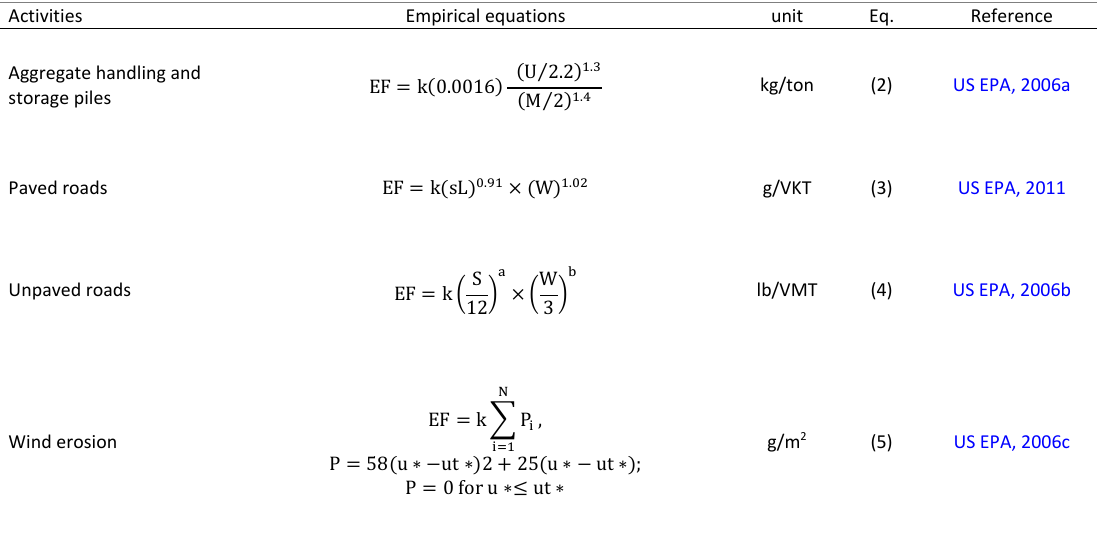
Table 2: Emission Factor equations for sand and gravel mining processes Activities Empirical equations unit Eq.